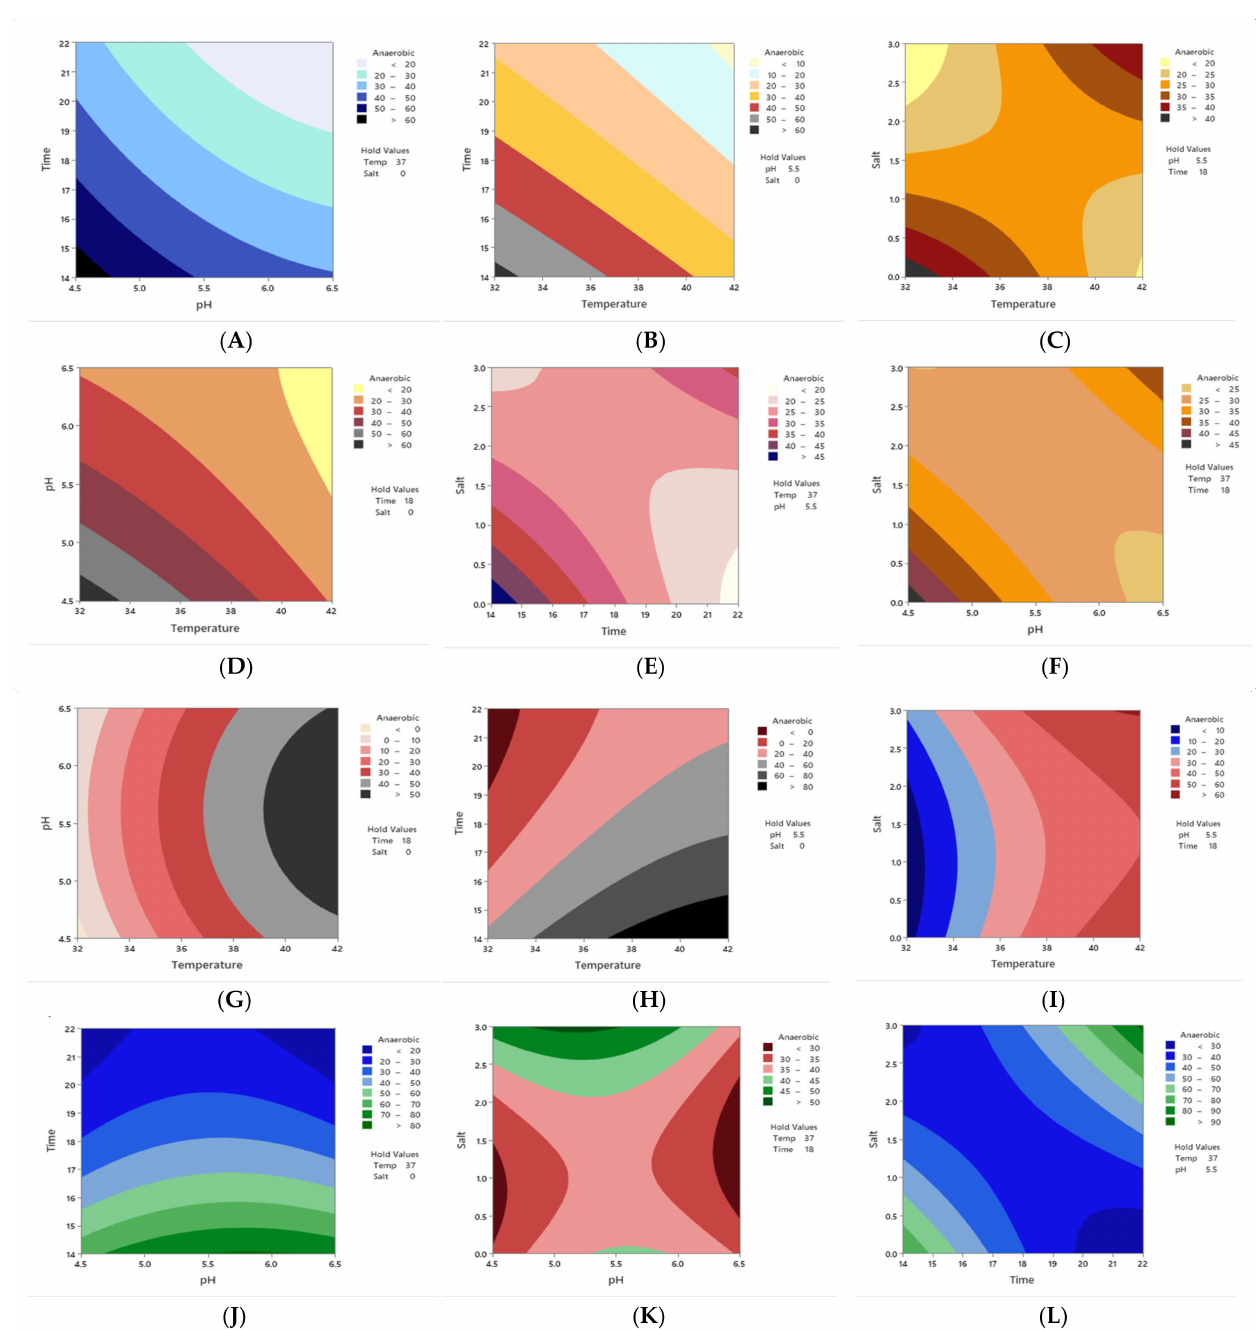
Figure 2. Contour plots of acrylamide removal in anaerobic conditions for S. lutetiensis ( A – F ) and L. plantarum ( G – L ) under controlled conditions of incubation time of 14–22 h, salt (NaCl) of 0.0–3.0%, and incubation temperature of 32–42 ◦ C and pH of